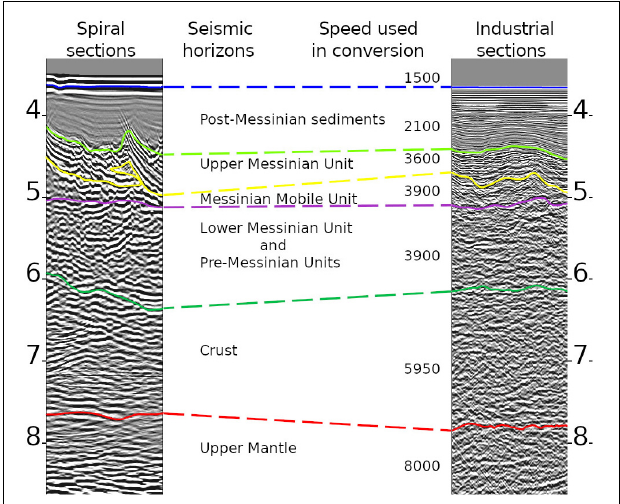
FIGURE 4 | A comparison of the seismic facies identified on SPIRAL (left) and industrial (right) sections in the deep Algerian basin. Vertical scales are in two-way-travel time and velocities in m/s. Velocity law modified after Leprêtre (2012); Bouyahiaoui (2014), Mihoubi (2014); Arab (2016), and Aïdi et al. (2018).